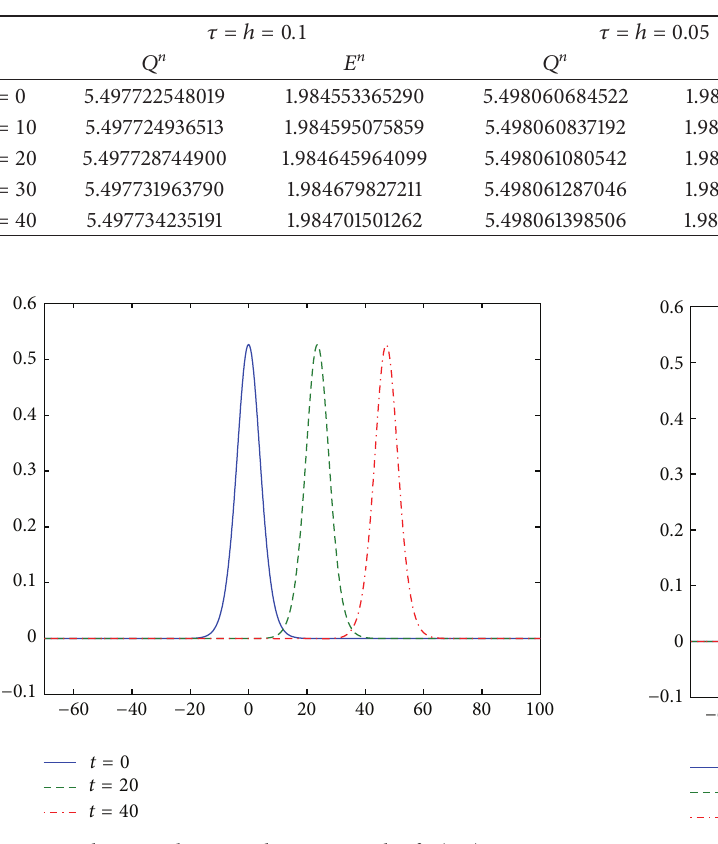
Figure 1: When 𝜏 = ℎ = 0.1 , the wave graph of 𝑢(𝑥,𝑡) at various times.